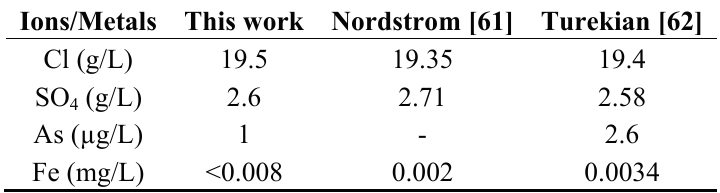
Table 1. Composition of sea water used in this study and comparison with literature values.